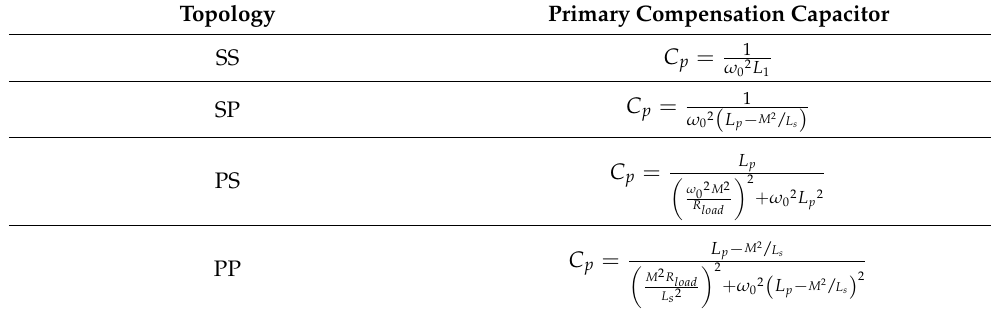
Figure 12. Basic compensation topologies. Table 2. Compensation capacitor equations